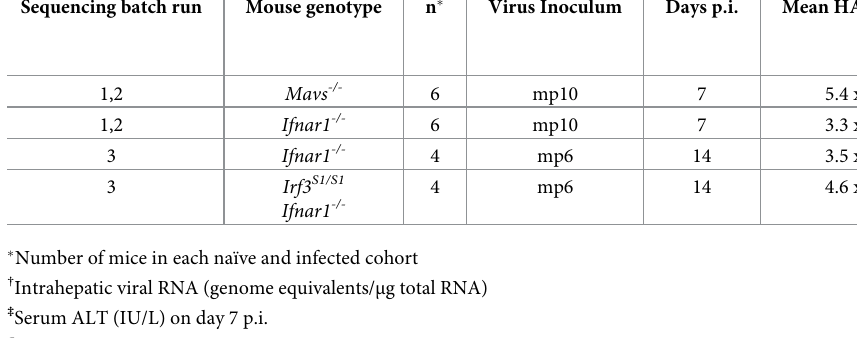
Table 1. High-throughput sequencing of intrahepatic RNA from HAV-infected mice. Sequencing batch run Mouse